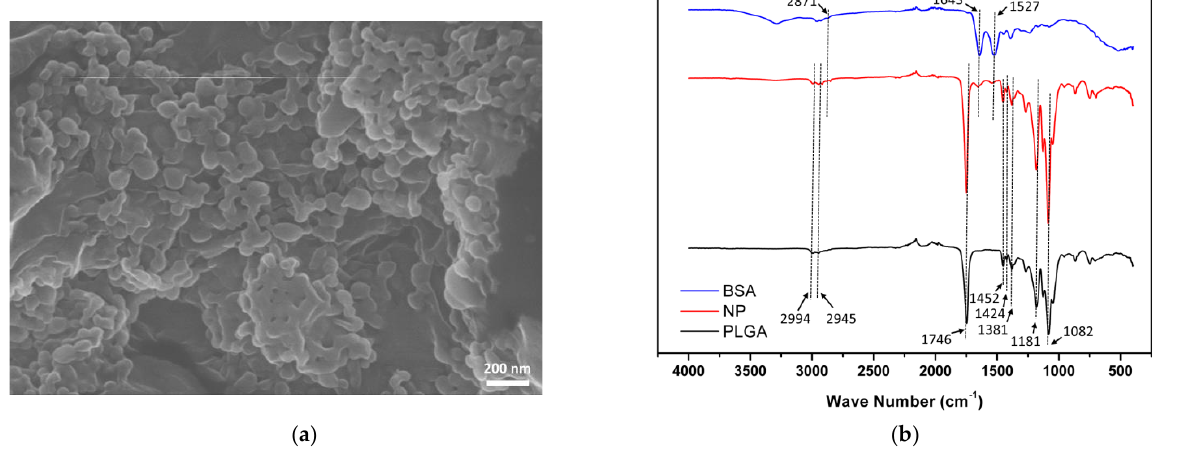
Figure 1. Characterization of BSA-laden PLGA nanoparticles. ( a ) SEM image of BSA-laden PLGA NPs. The nanoparticles were spherical with a smooth surface, yet some aggregation occurred due to freeze-drying procedure. ( b ) ATR-FTIR spectra of bovine serum albumin (BSA), BSA-laden PLGA NPs (NP), and PLGA. PLGA spectra (black curve) had three characteristic peaks attributed to the three different monomer sequences of PLGA polymer chains of lactide − glycolide at 1381 cm − 1 , glycolide-glycolide at 1424 cm − 1 , and lactide-lactide at 1452 cm − 1 . BSA spectra (blue curve) had typical protein characteristic peaks at 1643 cm − 1 (amide I) and 1527 cm − 1 (amide II). NP spectra (red curve) had the characteristic peaks of both BSA spectra and PLGA spectra, indicating successful encapsulation of BSA into PLGA nanoparticles.